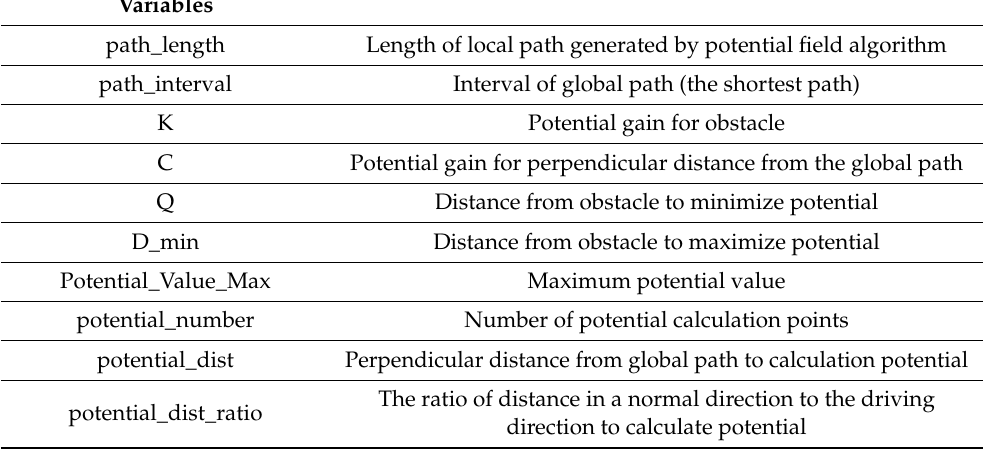
Figure 6. Variables for potential field simulation. Table 1. Simulation variables.